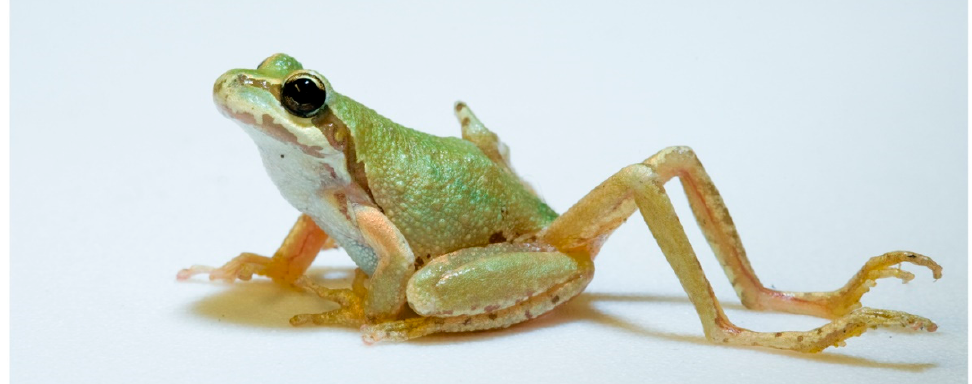
Figure 2. Pacific chorus frog ( Pseudacris regilla ) with hind limbs malformation induced by the infec- tion with the trematode Ribeiroia ondatrae . Source: Goodman and Johnson, 2011 [51], licensed under CC BY 2.5.